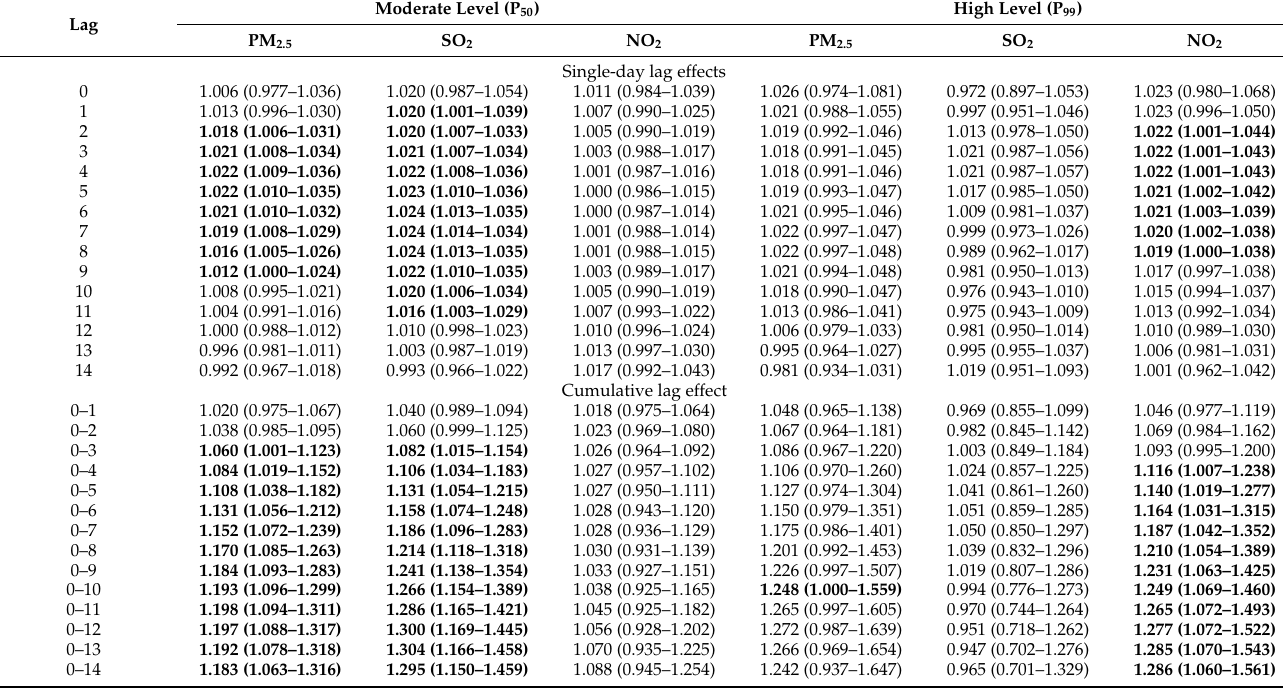
Table 2. The RR and 95% confidence interval of ambient pollutants on outpatient visits for pneumonia